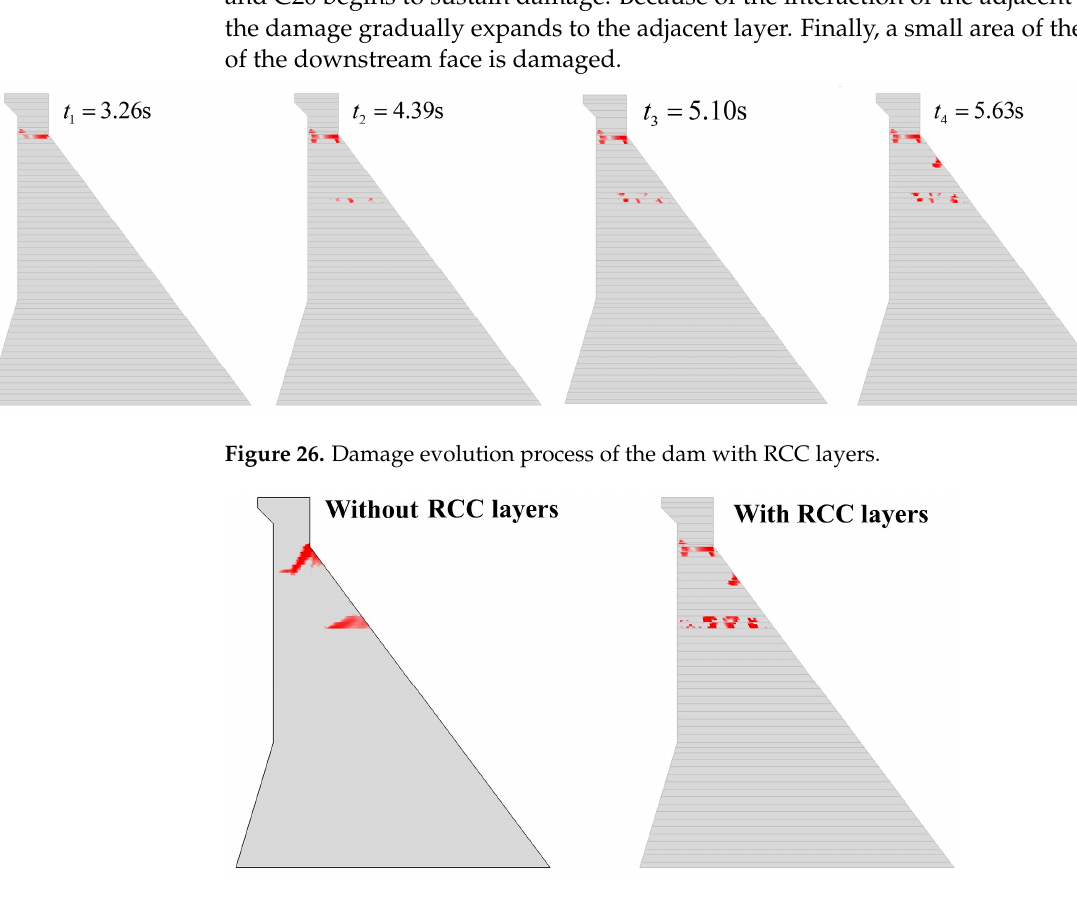
Figure 27. Final damage profiles with and without RCC layers.